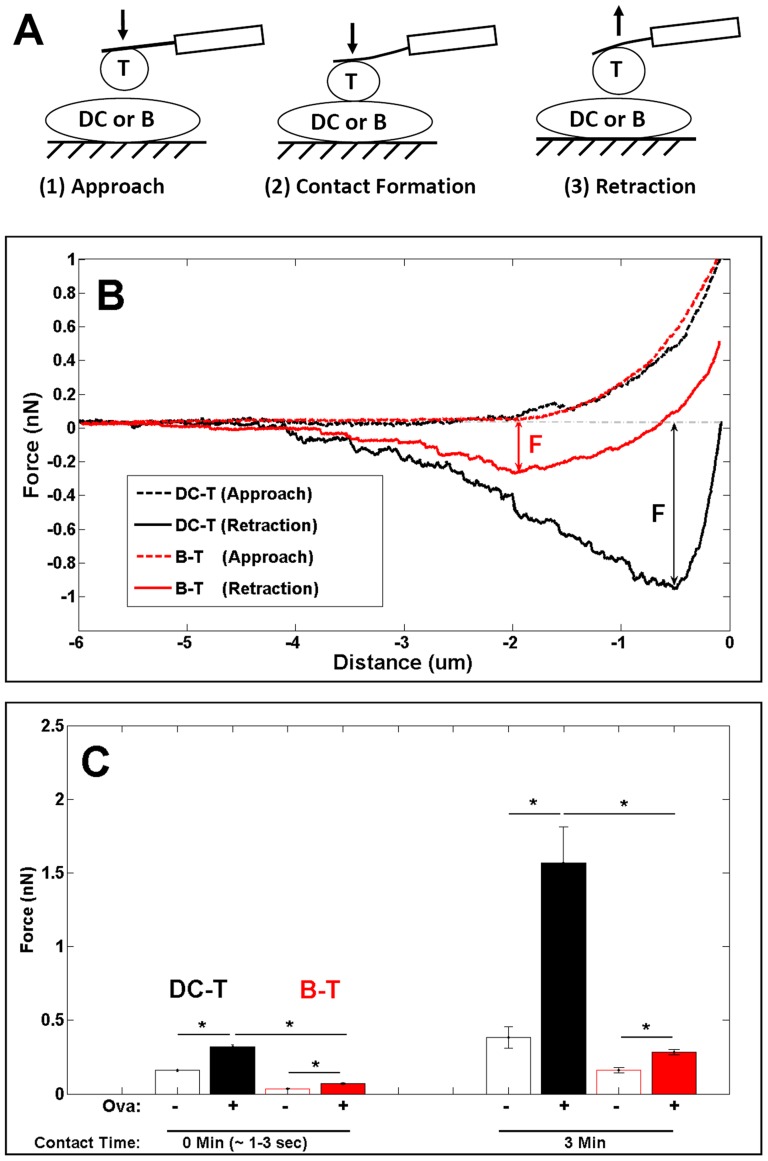
Differential Strength of Mechanical Forces between APC:T-cell Conjugates.(A) Schematic illustration of AFM experiments. A T-cell-mounted AFM cantilever was placed above a DC or B-cell that was firmly attached to a glass cover slip. The T-cell was then brought into contact with the target cell. Interaction forces were measured by the deflection of the cantilever after a pre-defined contact time. (B) Corresponding force-distance curve of DC:T-cell (black) or B:T-cell (red) interactions. F represents maximal interaction force (double arrow). (C) Interaction forces of DC:T-cell (black) or B:T-cell conjugates (red) in the absence (-Ova) or presence of Ova peptide (+Ova) for contact time of ∼1–3 sec and 3 min. *p<0.01, unpaired t-test. Bars indicate mean ± s.e.m (n>10 pairs of cells). For each condition, OT-I T-cells were isolated from >3 independent experiments.